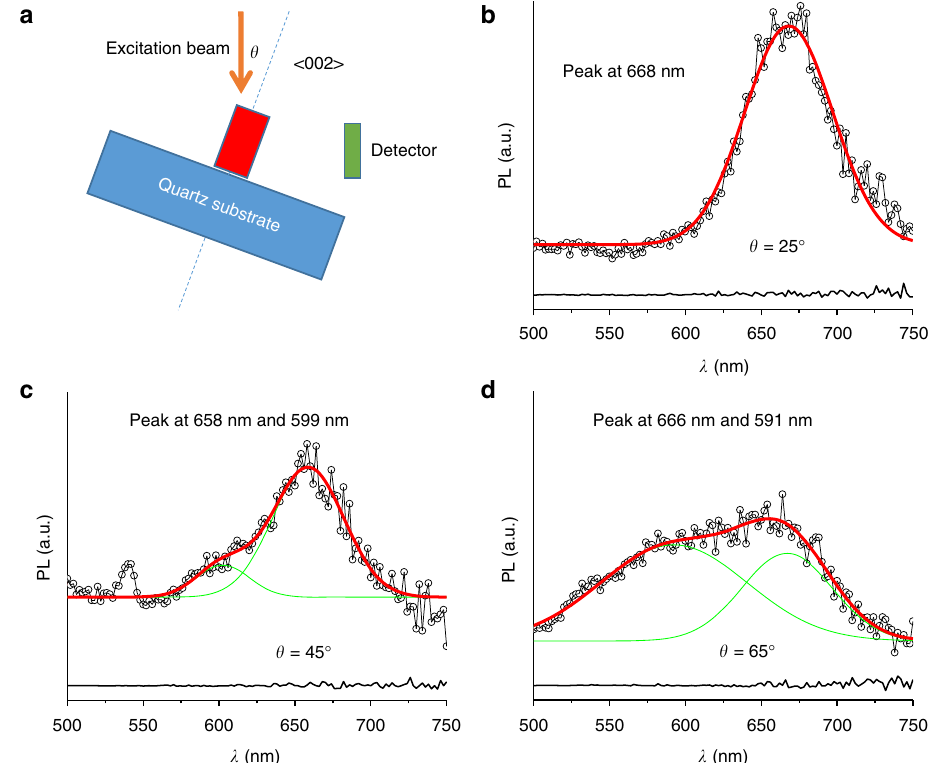
Fig. 3 Photoluminescence (PL) anisotropy of (CH 3 NH 3 ) 3 Bi 2 I 9 coating. a Experimental set-up and coating orientation. The detector and incident angle are positioned at right angles and the substrate is rotated to control the angle. The sample is positioned vertically and the wavelength of incident beam is 350 nm. b – d show the respective PL spectra at 25°, 45° and 65°. The black lines at the bottom of b – d are the PL measurement on the bare fused silica substrate at the respective